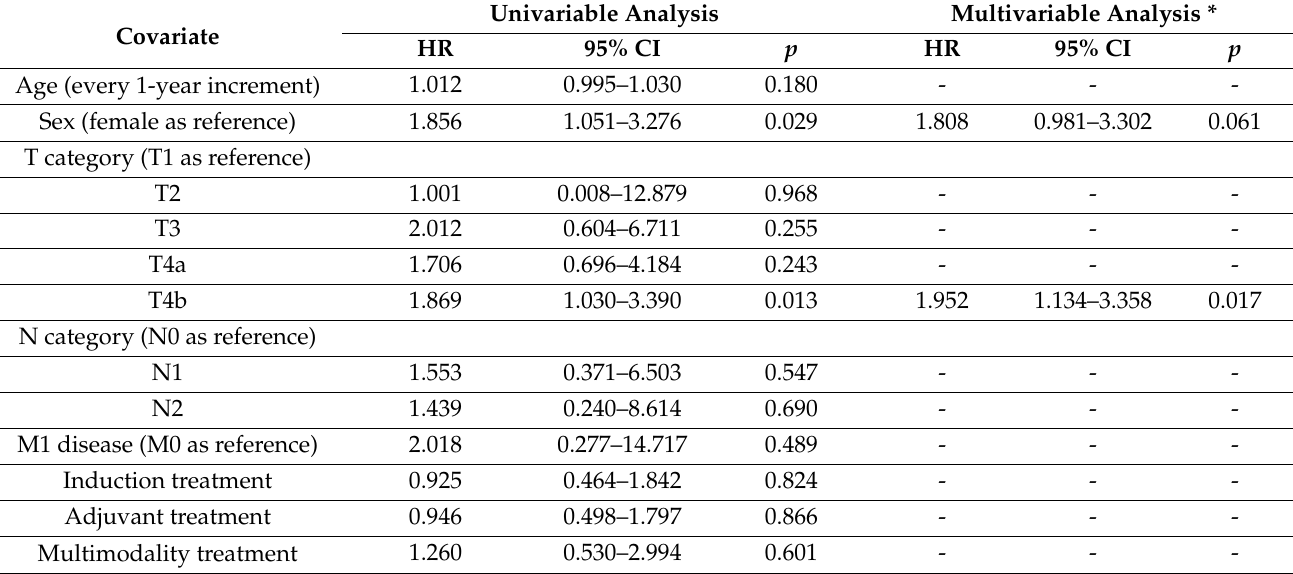
Table 3. Univariable and multivariable analyses of variables prognostic of overall survival.